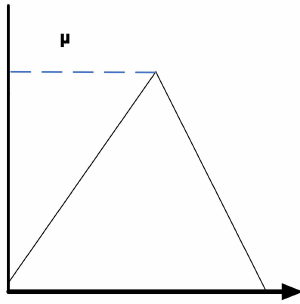
Figure 5. Type 1 Fuzzy.